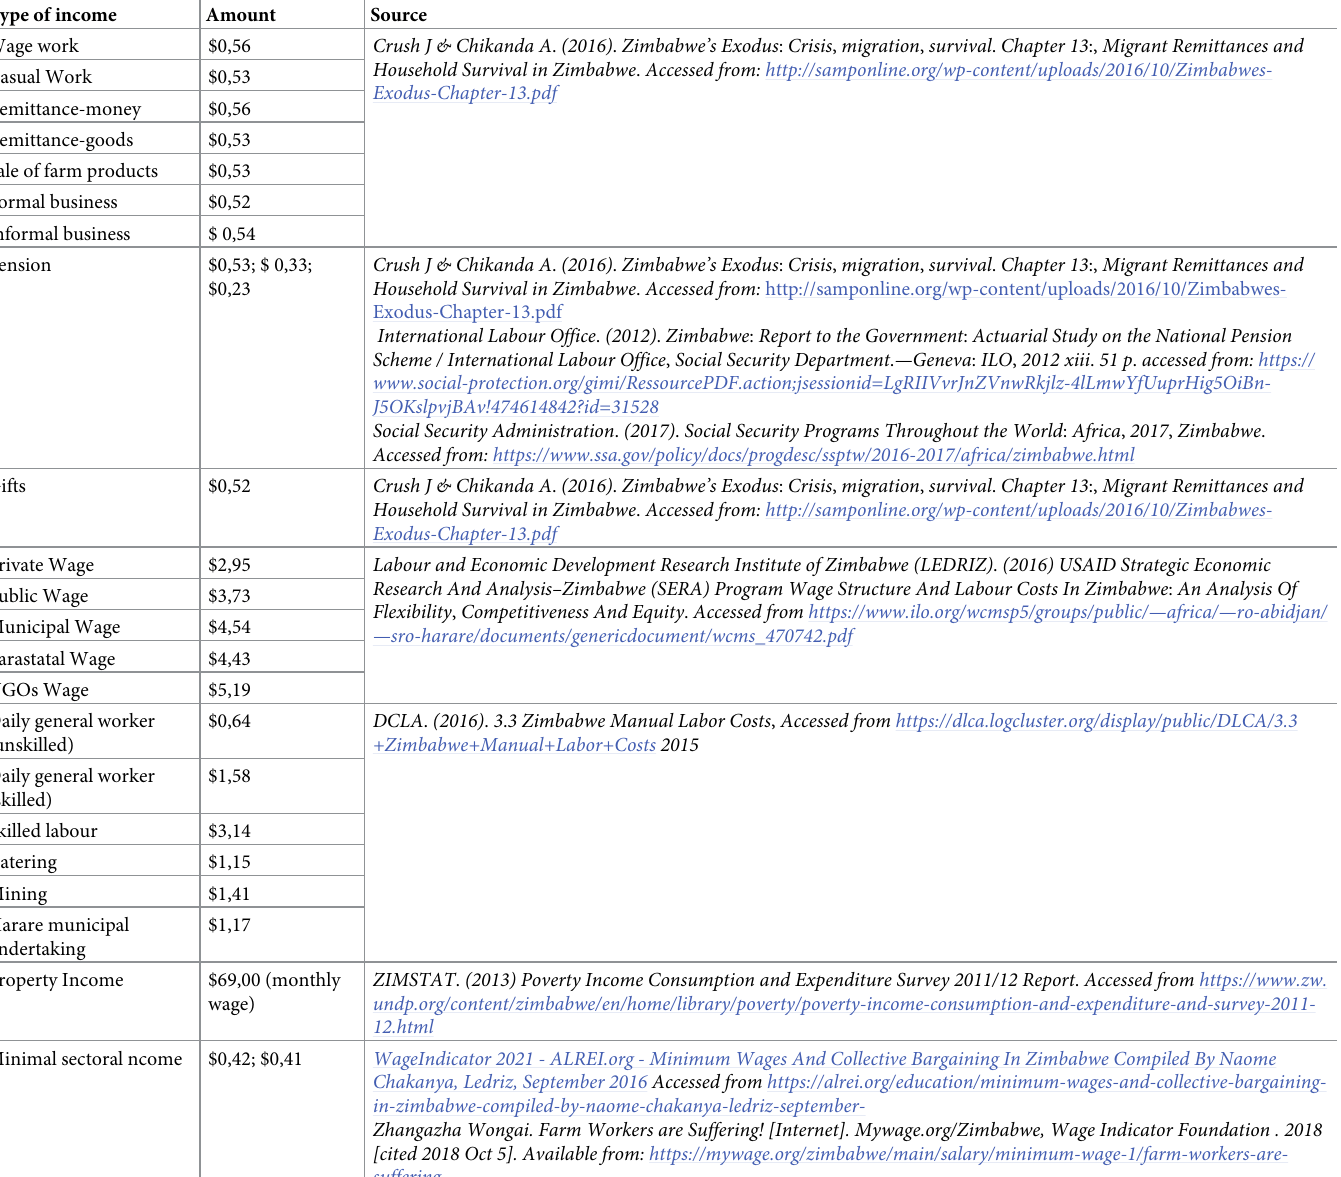
Table 1. Source and type of